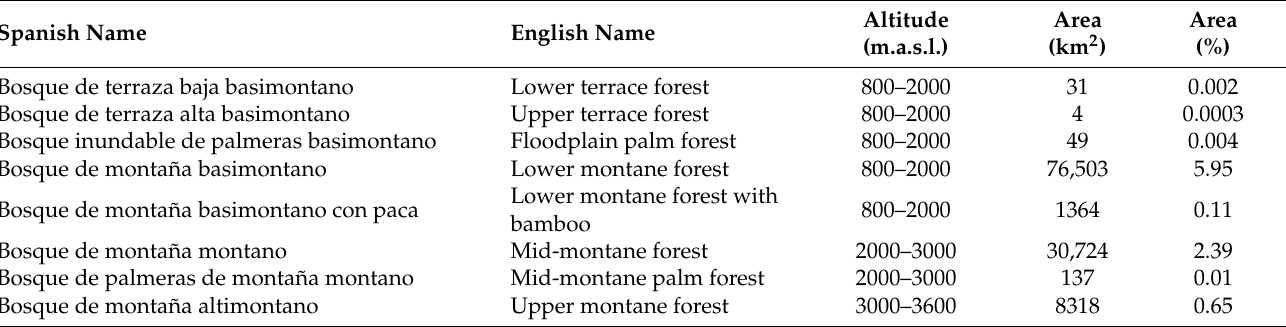
Table 1. Montane forest